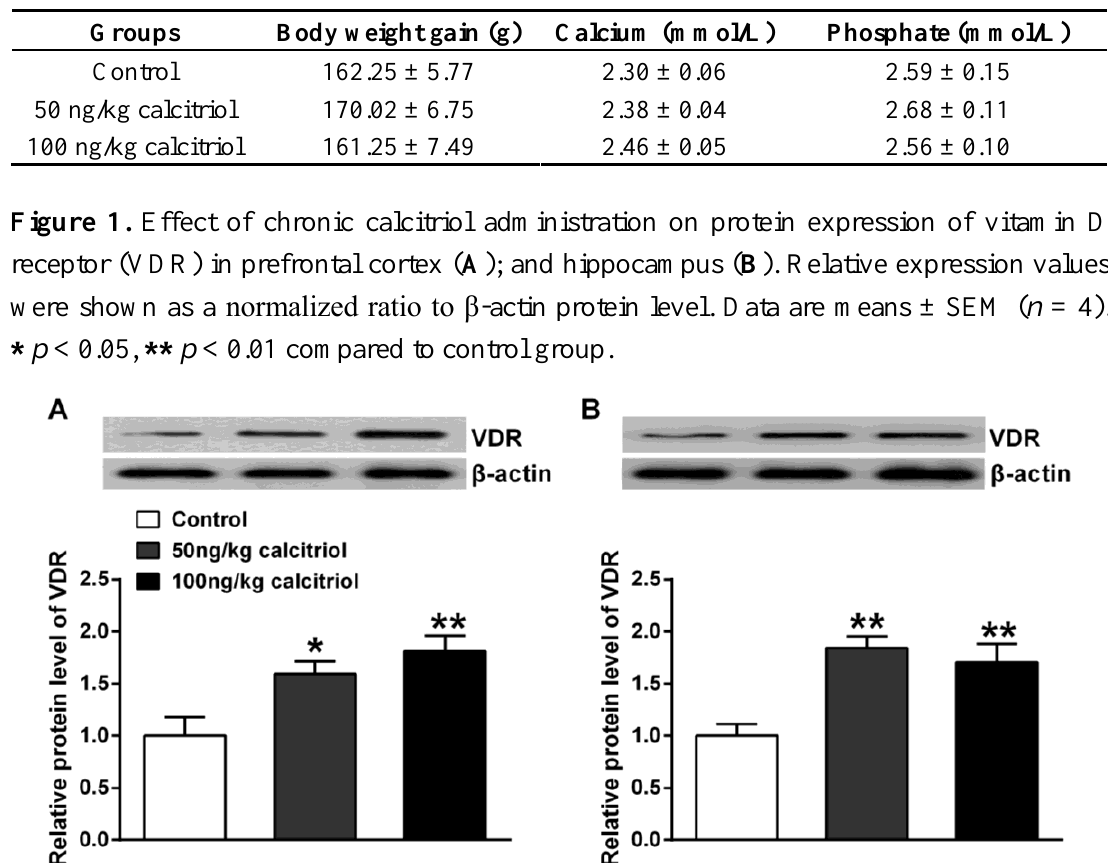
Table 2. Effect of chronic calcitriol administration on body weight gain and serum status of calcium and phosphate. Data are means ± SEM ( n = 8).